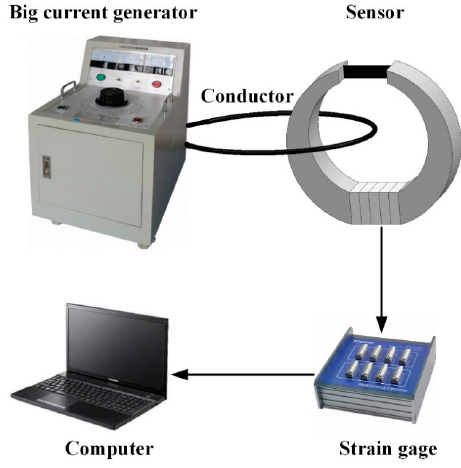
Figure 10. Testing device of sensor.